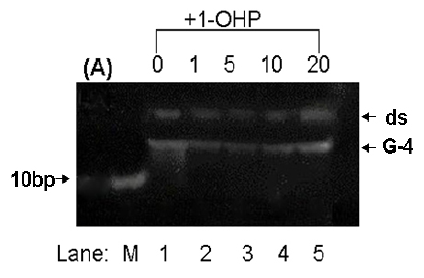
Figure 7. PAGE image of p53 DNA with the addition of 1-OHP solution in different molar ratio. (Lane M): DNA marker, (Lane 1–5): the molar ratio of DNA and 1-OHP is 1:0, 1:1, 1:5, 1:10 and 1:20,